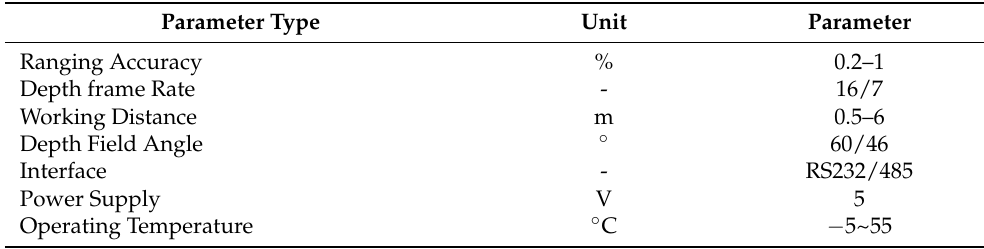
Table 1. Basic technical parameters of system